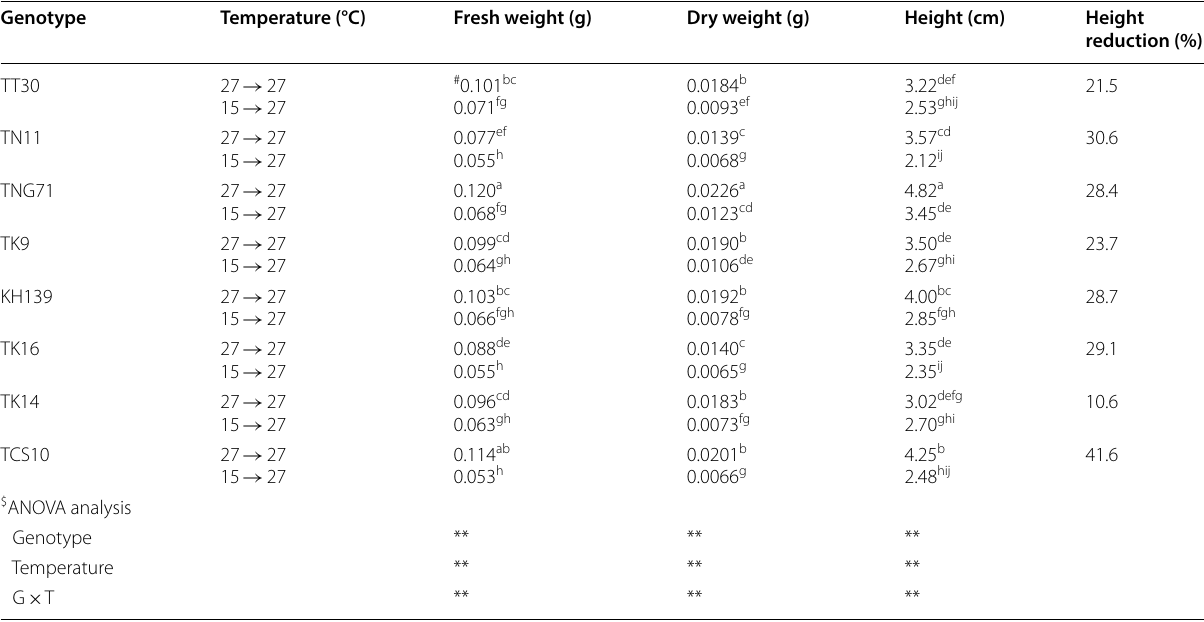
The temperature was set at 15 °C for cold treatment and 27 °C for control. After 4 days of treatment, the temperature was adjusted to 27 °C for 3 days before harvesting # Different letters represent the significant difference with LSD tests among cultivars or treatments (p < 0.05) $ G T: effect of genotype and temperature interaction; *p < 0.05; **p < 0.01